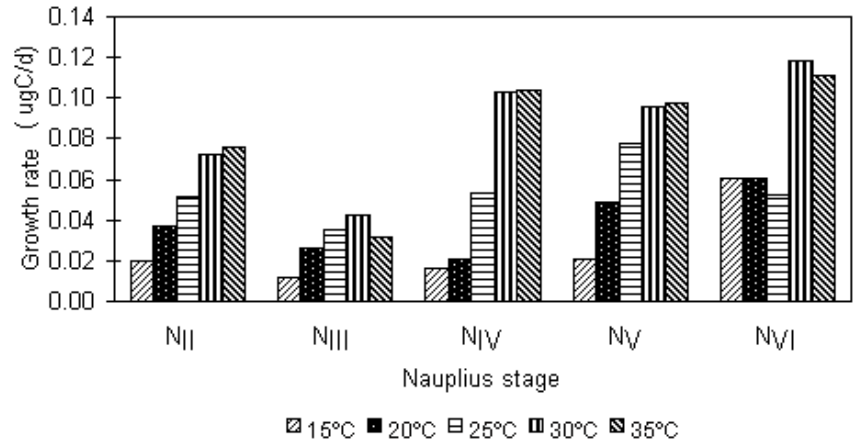
FIGURE 3. Effect of temperature on growth rate of P. dubia